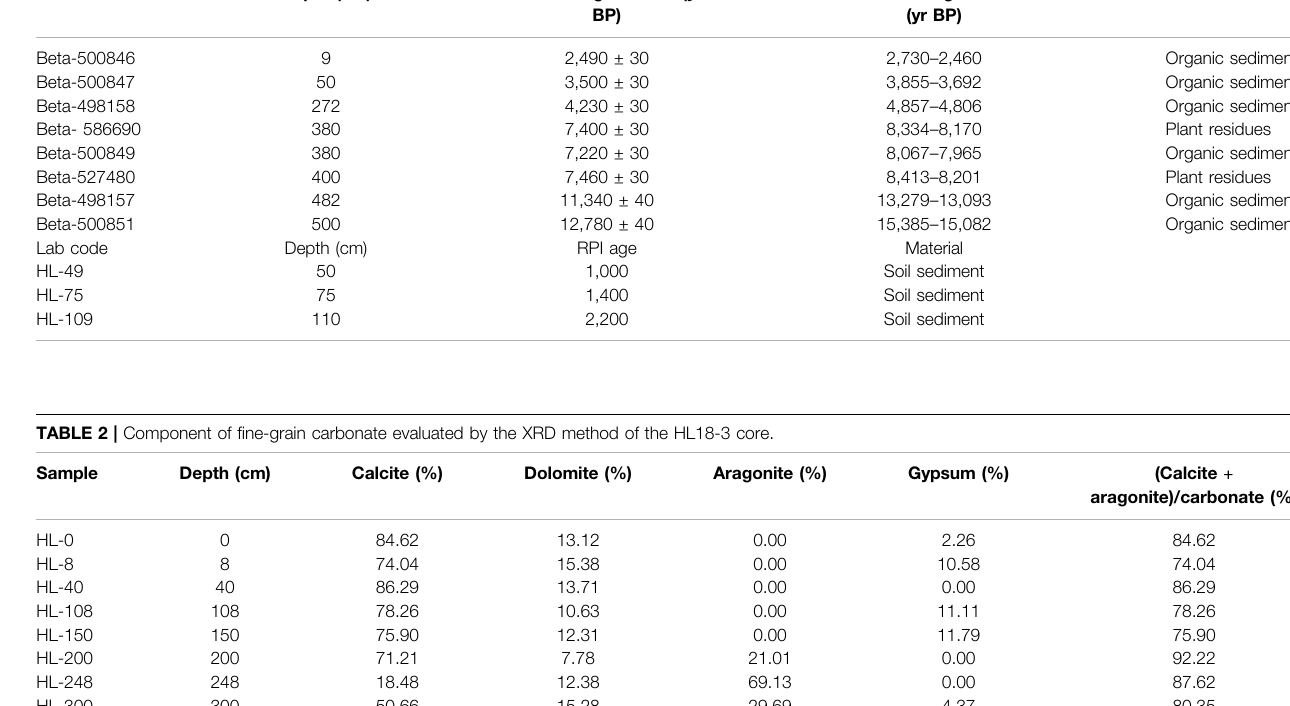
TABLE 1 | AMS 14 C radiocarbon dates and RPI age from the HL18-3 core in the northeastern TP. Lab code